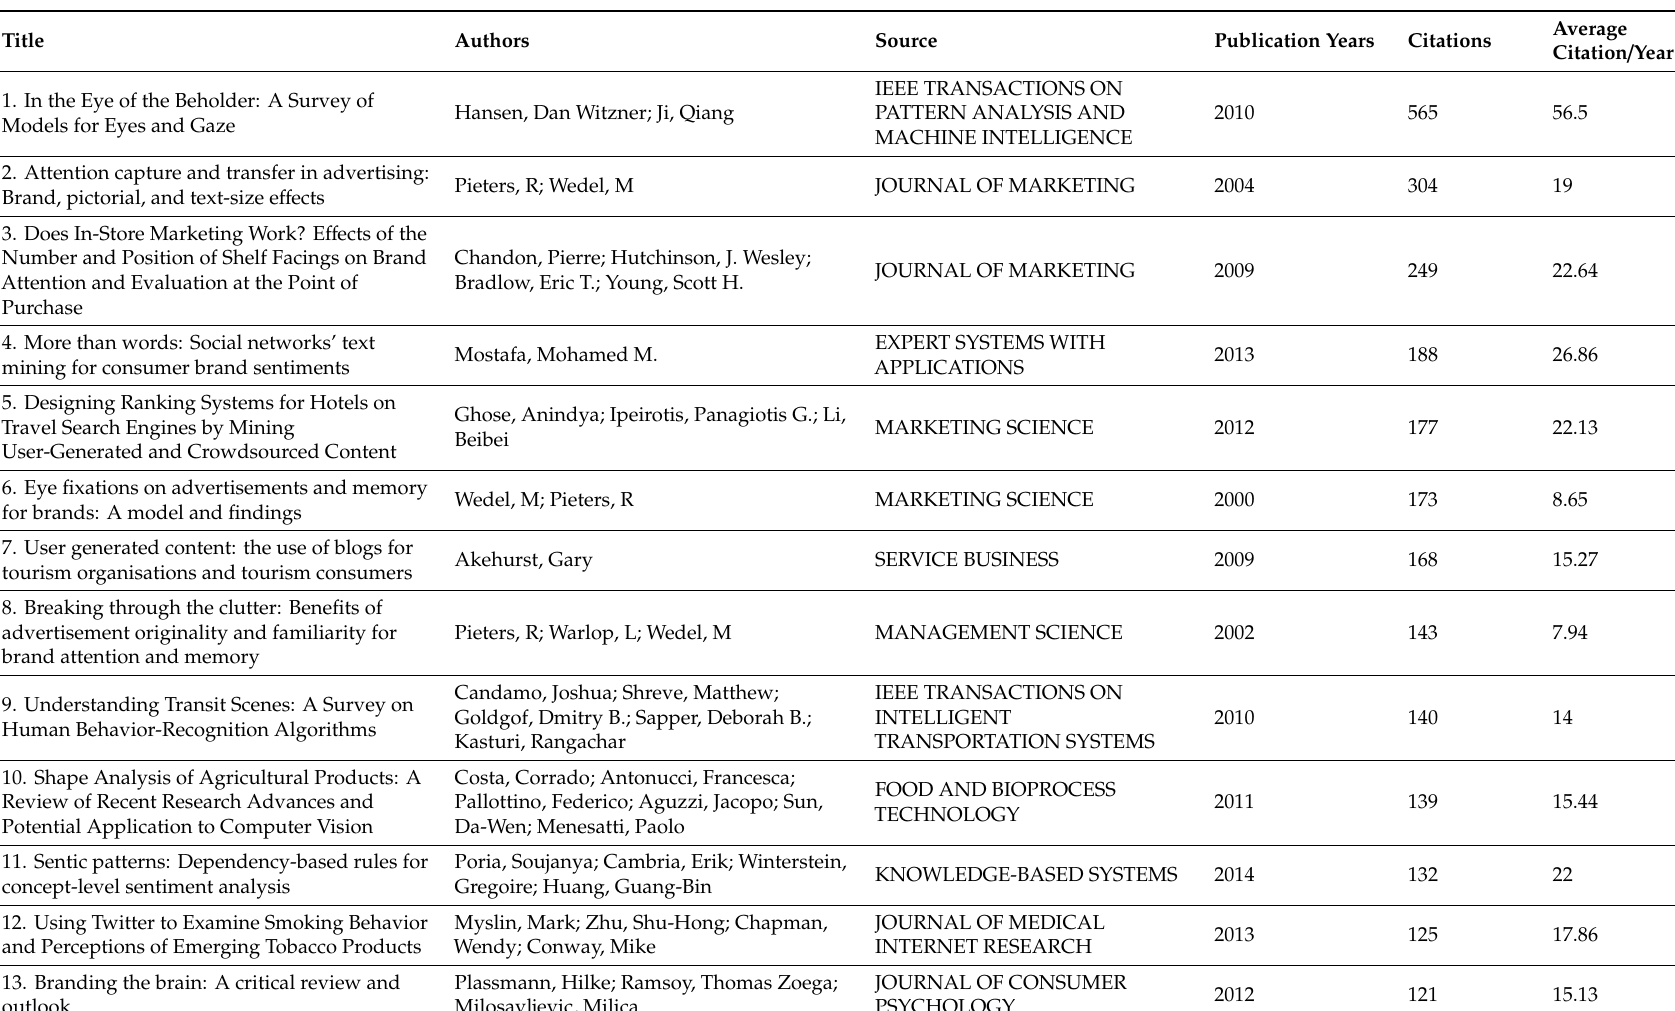
Table 5. The Top 25 Times-Cited Works analysis. The relatedness of items is determined based on the number of times they are cited